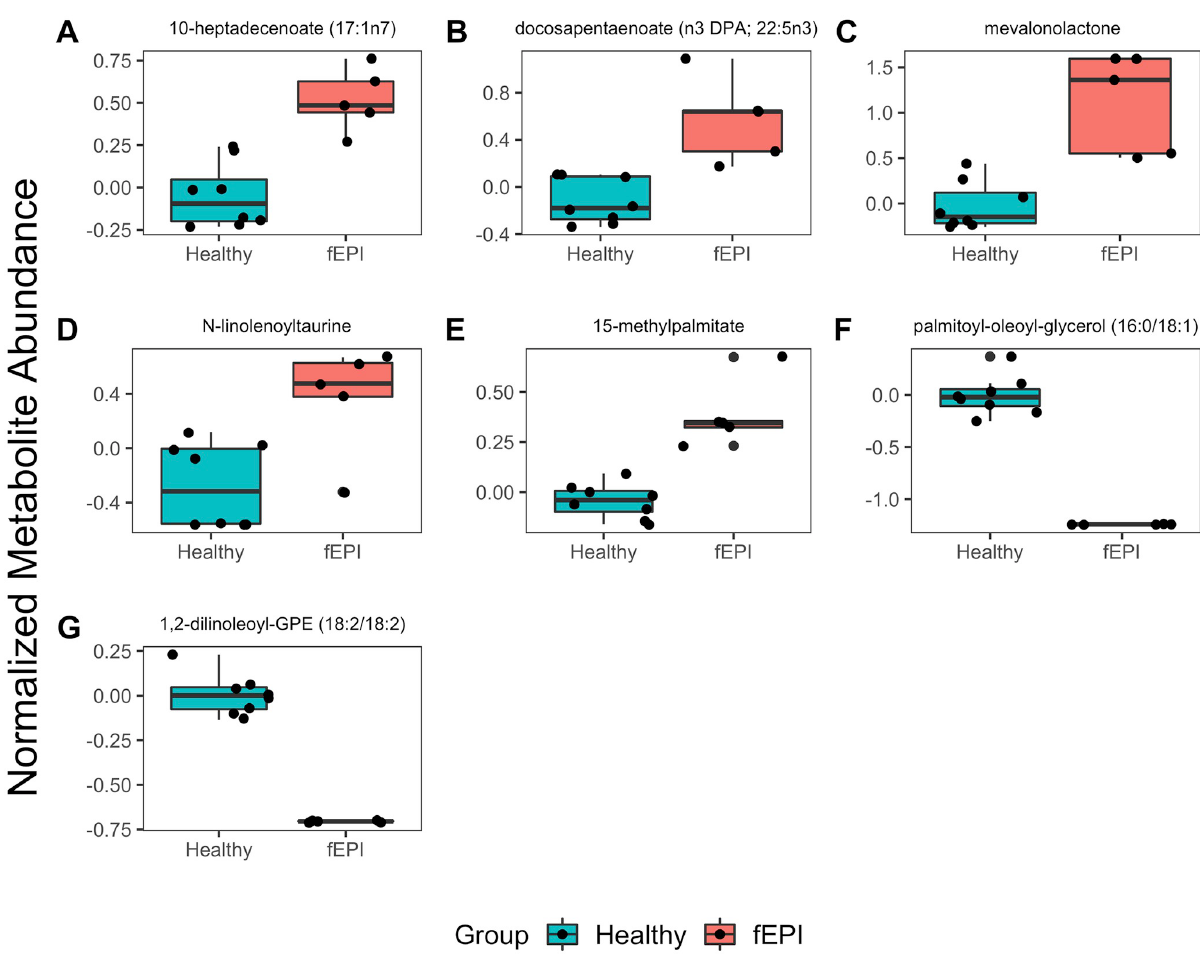
Fig 3. Comparison of selected metabolites from significantly enriched metabolic sub-pathways. Selected metabolites were important drivers of metabolic sub-pathway enrichment and varied significantly between cats with EPI and healthy controls. A. 10-heptadecenoate (17:1n7), long chain fatty acid; B. docosapentanoate (DPA, 22:5n3), polyunsaturated fatty acid; C. mevalonolactone, mevalonate metabolism; D . N-linolenoyltaurine, endocannabinoid; E . 15-methylpalmitate, branched fatty acid; F. palmitoyl-oleoyl-glycerol (16:0/18:1), diacyclglycerol; G. 1, 2-dilinoleoyl-GPE (18:2/ 18:2),